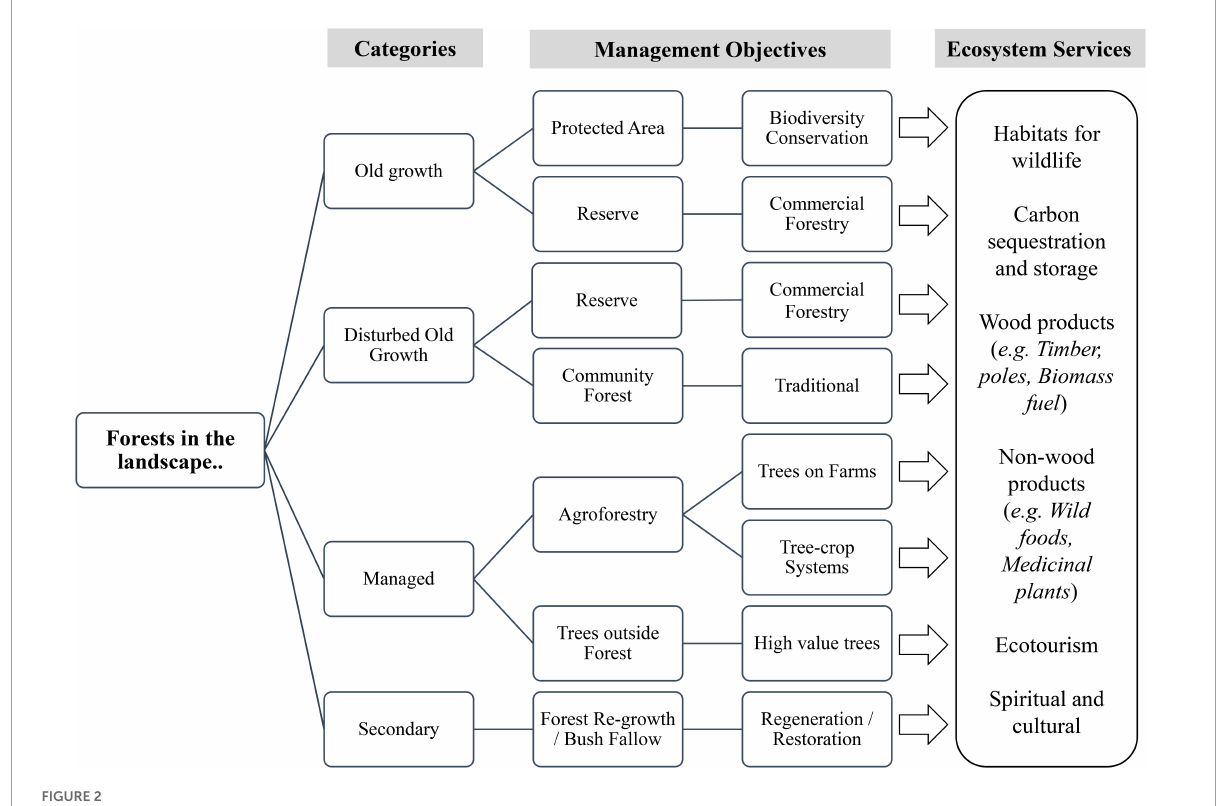
FIGURE2 Proposed framework for characterization of forests